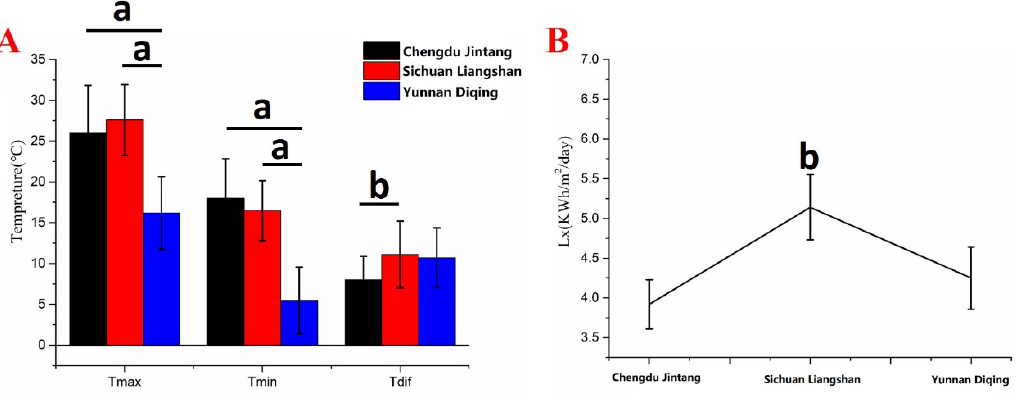
Figure 2. The average maximum temperature (Tmax), minimum temperature (Tmin), and diurnal temperature difference (Tdif) of each area ( A ) and the average light intensity in each area ( B ). These values were calculated from 1 March to 31 August 2021. Note: a p < 0.01, with significant difference, b p < 0.05, with extremely significant difference.